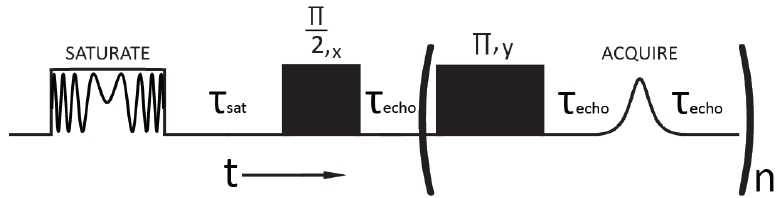
Figure 2. Modified saturation recovery pulse sequence that incorporates a ±75 kHz frequency sweep into the saturation pulse. The CPMG backend is required to observe a signal because of the large inhomogeneous static field and rf circuit ring down. The variable frequency rf pulse more efficiently saturates the magnetization in single sided mode in comparison to the conventional rf pulse train used for sample-in-the-coil